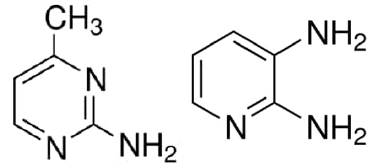
Figure Figure 1. The structures of the ligands: 2-amino-4-methylpyrimidine (AMPY) and 2,3-diamino- pyridine (DAPY).